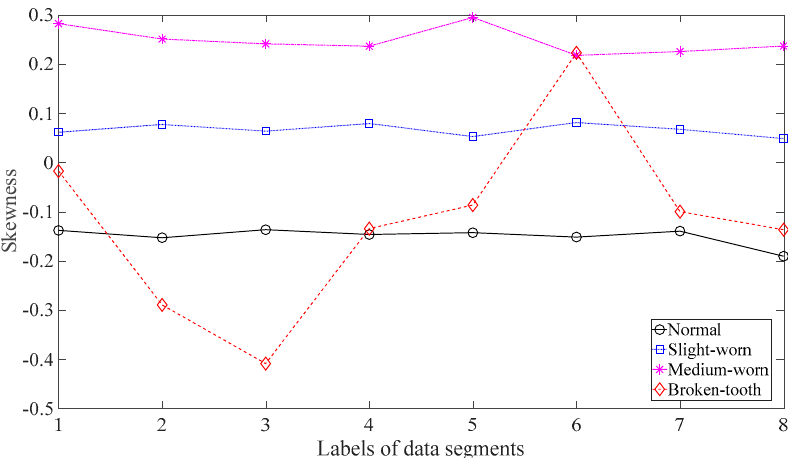
Figure 4. Skewness of the four types of gear vibration data.